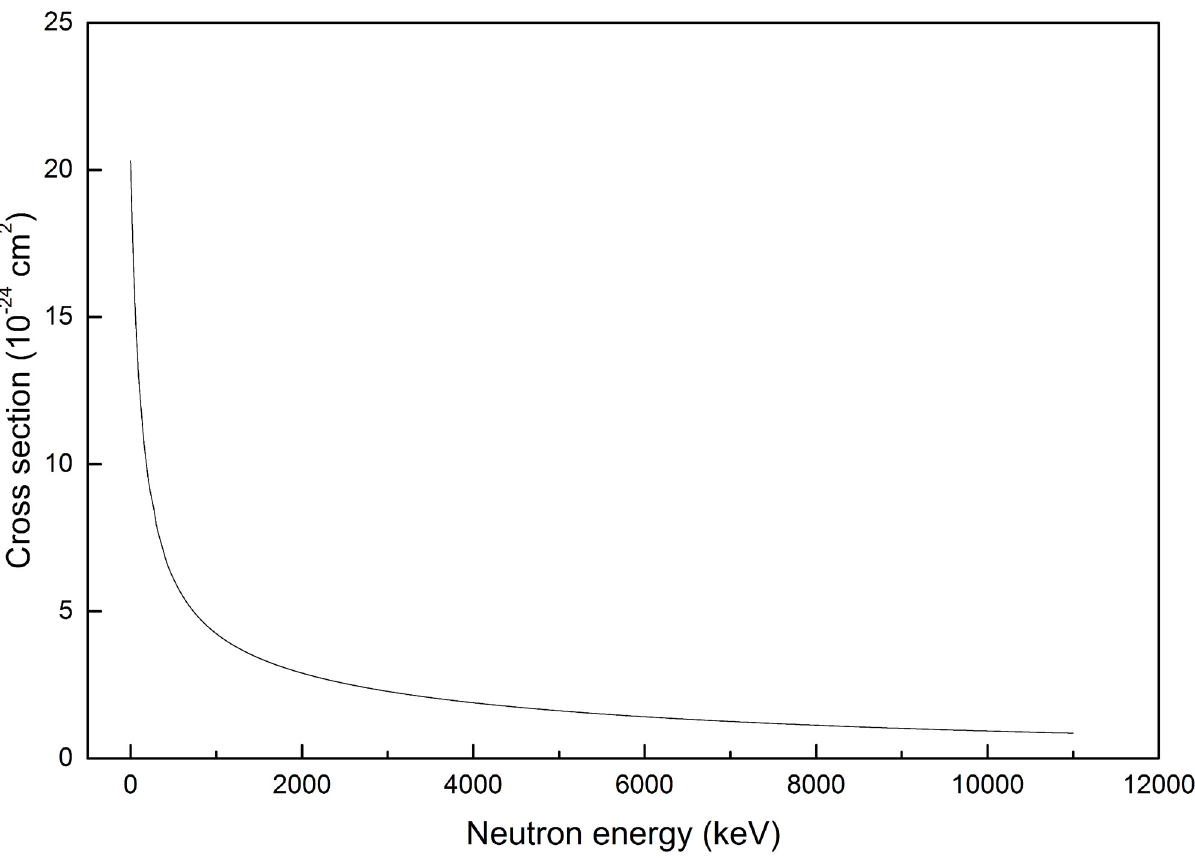
Fig 2. Elastic scattering cross section for